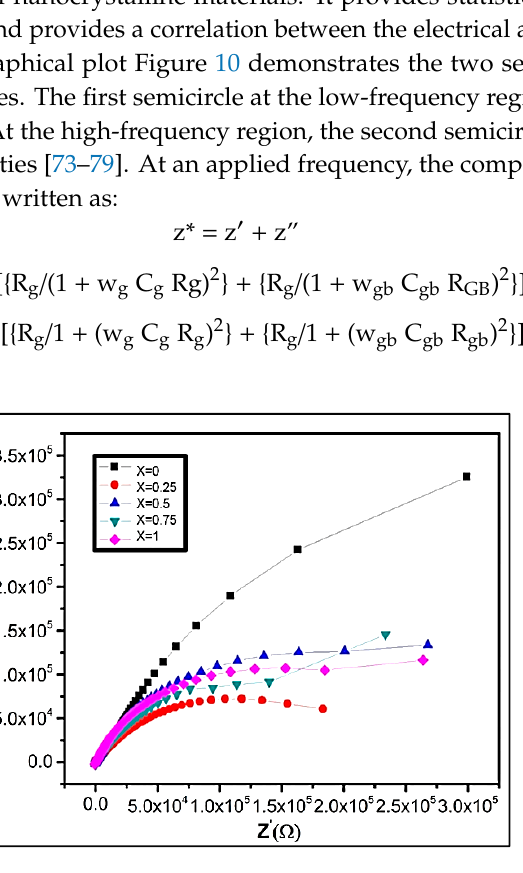
Figure 10. Cole–Cole plot of Ni 1-x Zn x Fe 2 O 4 samples at room temperature.